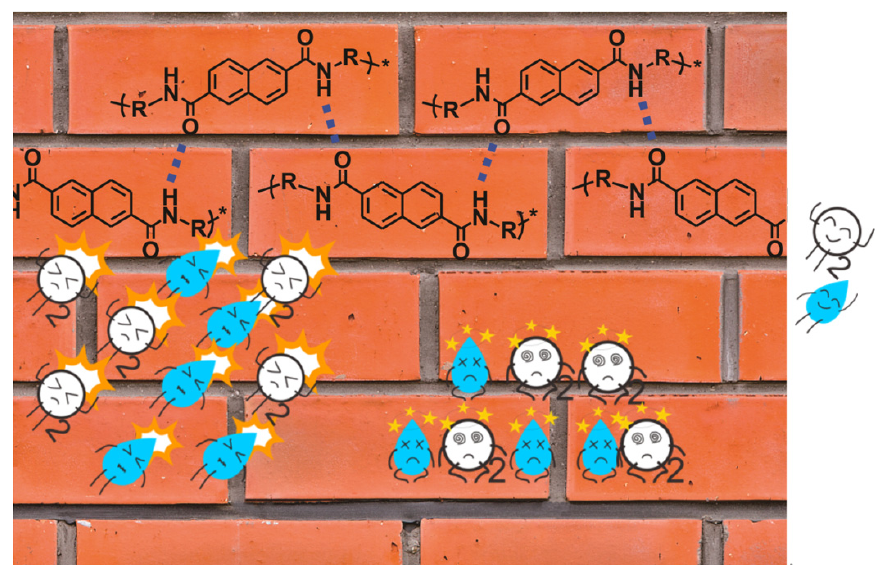
Figure 16. The barrier mechanism of NAPPI conceptually metaphorized as the “wall”.